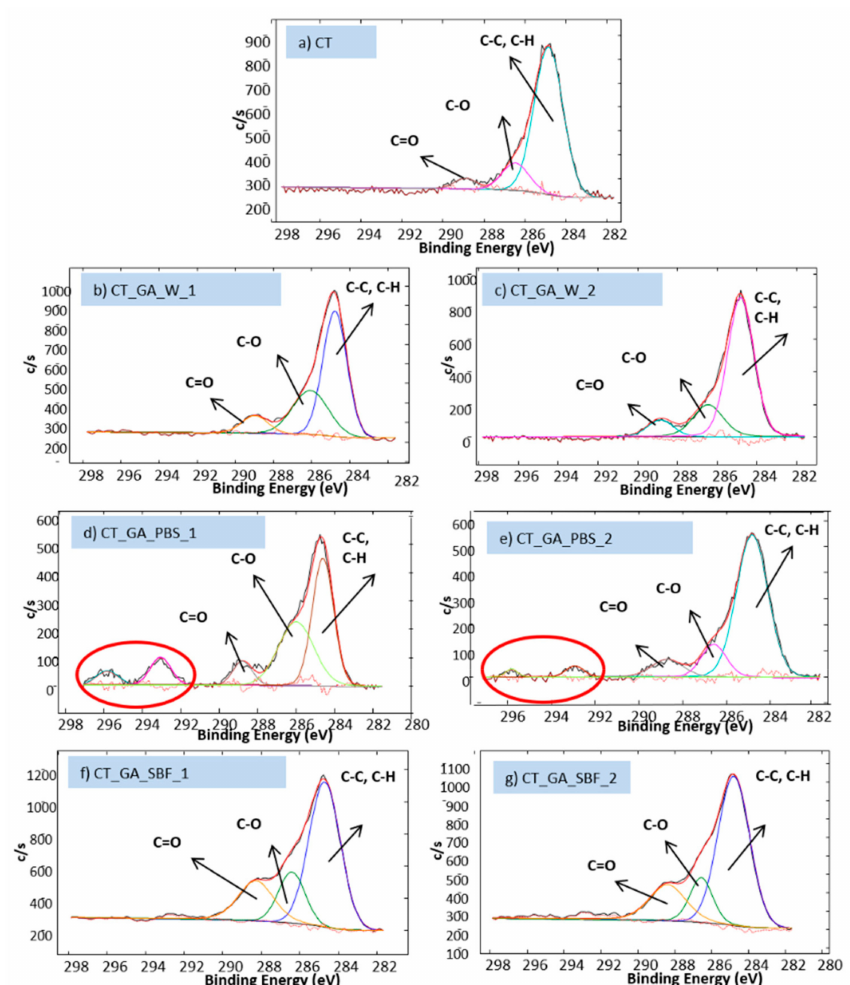
Figure 3. XPS high-resolution spectra of carbon region. ( a ) CT; ( b ) CT_GA_W_1; ( c )